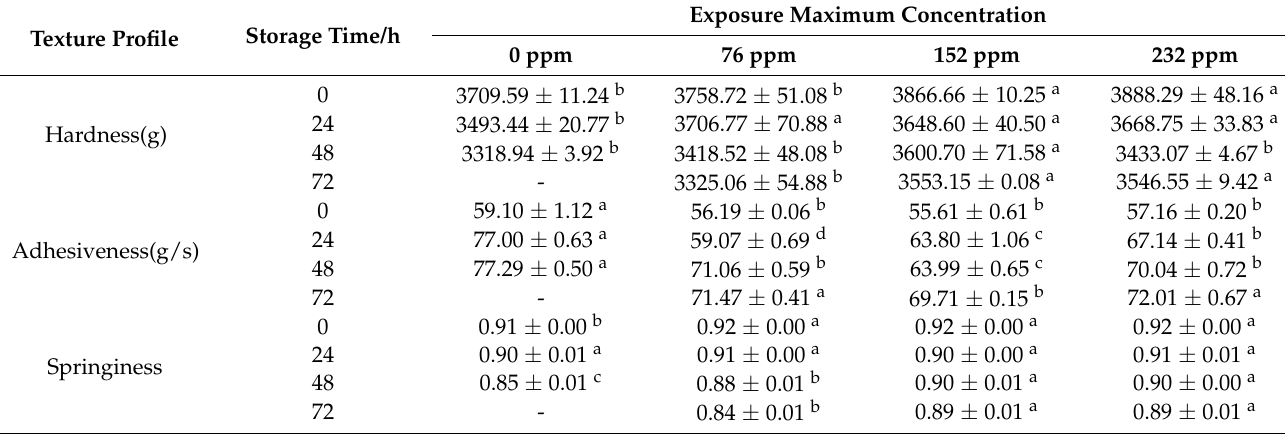
Table 2. Effect of chlorine dioxide gas treatment on the changes of texture properties of FBNs during storage. Texture Profile